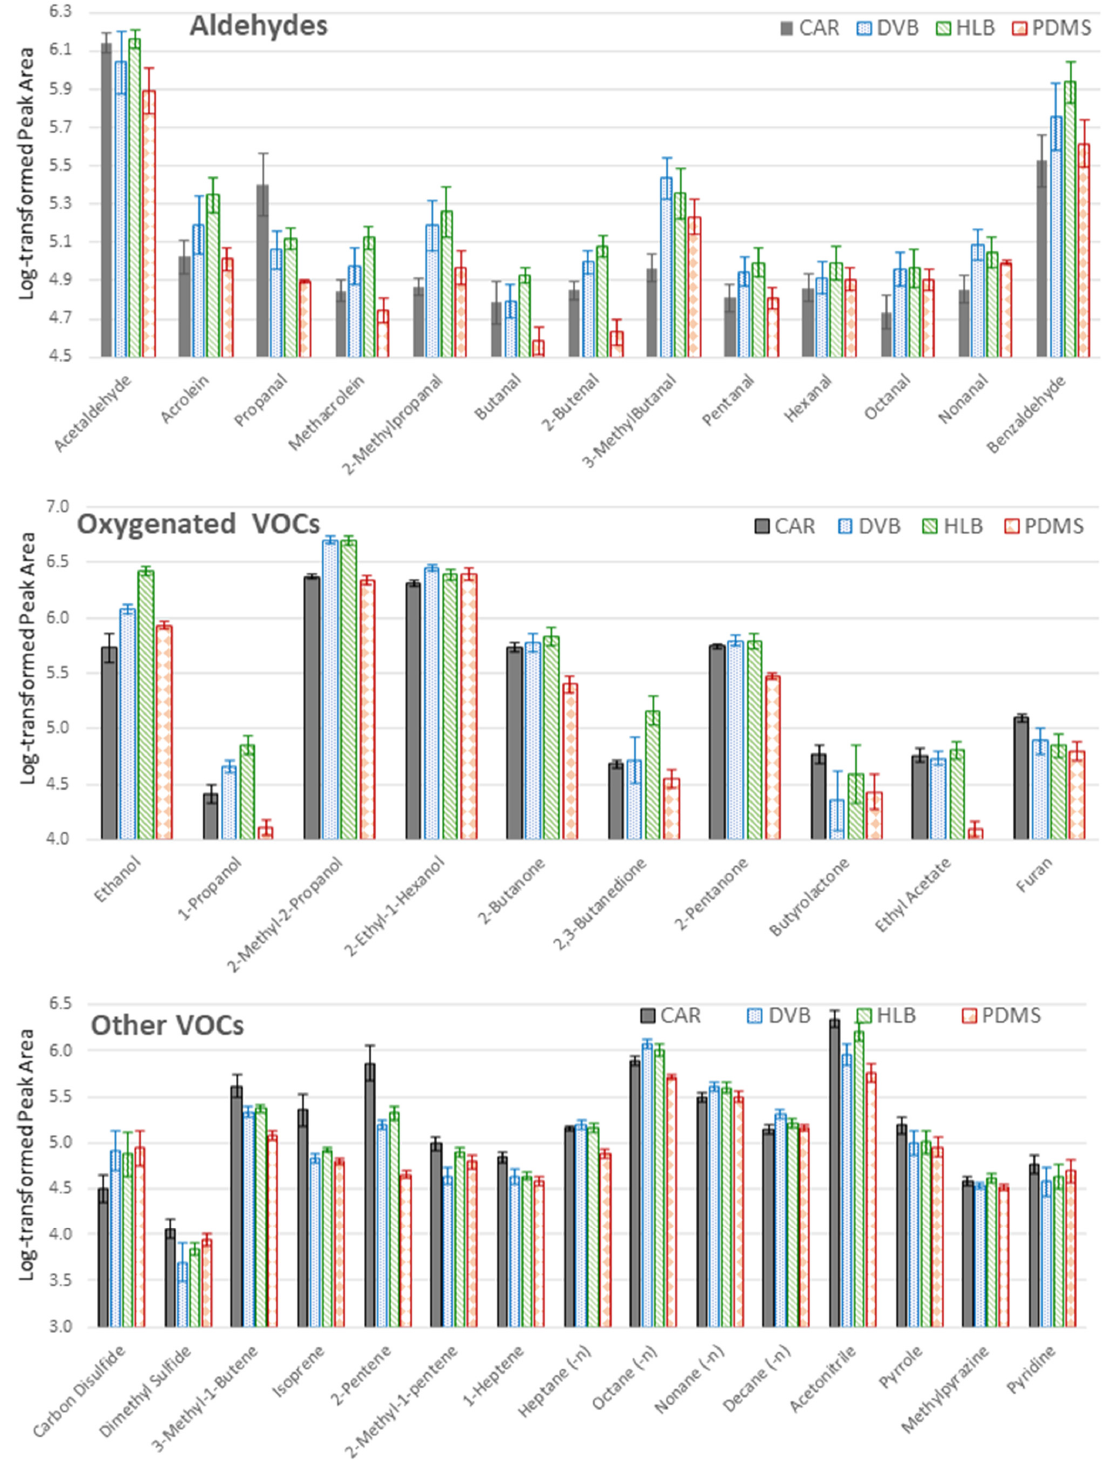
Figure 1. Sorbent optimization of volatile organic compounds (VOCs). The y -axis represents log-transformed peak area values. Mean values are given with standard deviation for four replicates ( n = 4) for each sorbent: Carboxen (CAR, grey boxes), divinylbenzene (DVB, blue boxes), hydrophobic − lipophilic balanced (HLB, green boxes), polydimethylsiloxane (PDMS, red